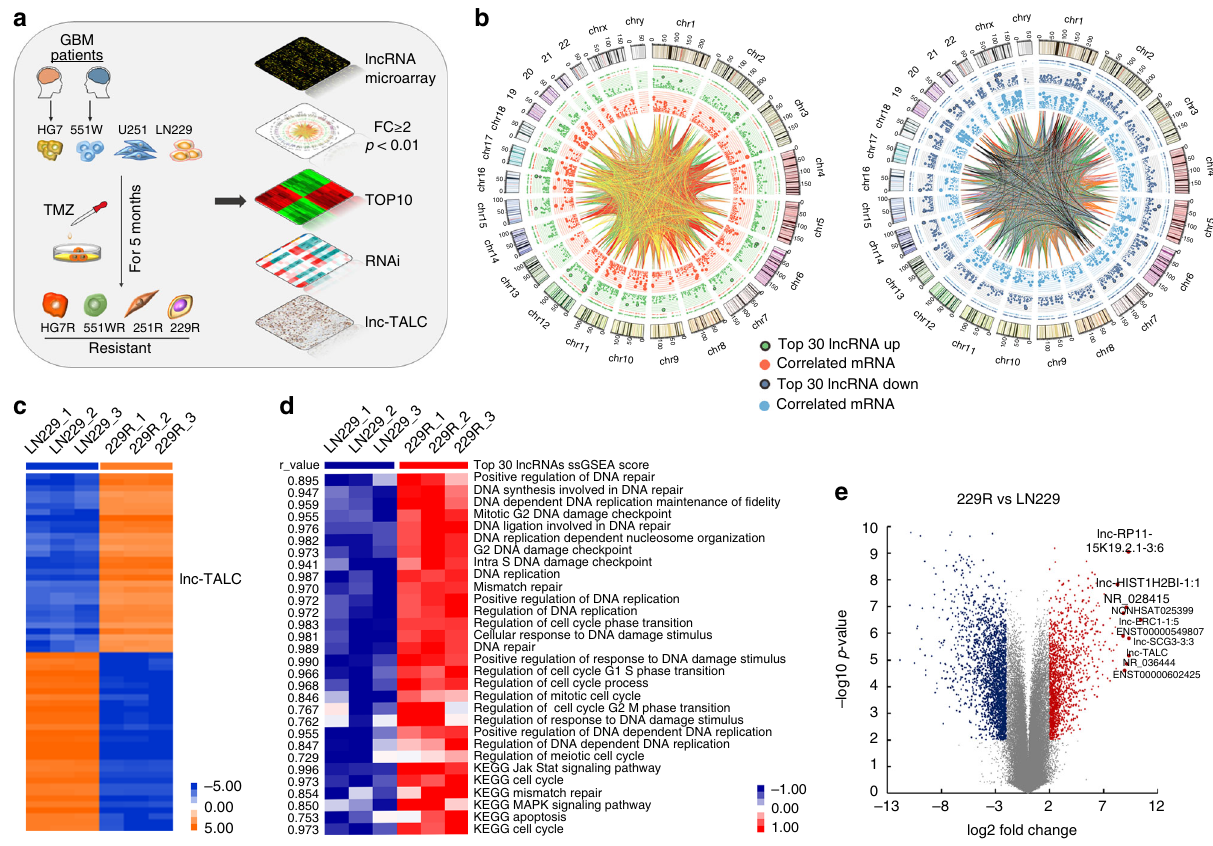
Fig. 1 LncRNA microarray detection of TMZ-resistant and parental GBM cells. a Schematic process to acquire TMZ-resistant GBM cells and to screen the lncRNA lnc-TALC. b The circos plot presents the genome-wide view of the top 30 up- or downregulated lncRNAs and the associations with mRNAs of TMZ-resistant GBM cells. c The heatmap shows the top 30 up- and downregulated lncRNAs in TMZ-resistant GBM cells. d The top 30 upregulated lncRNAs associated with functional gene sets of TMZ-resistant GBM cells are shown in the heatmap. e The top 10 upregulated lncRNAs between LN229 and 229R cells are listed in the volcano plot of DNA methyltransferase also had no effect on the lnc-TALC then selected 56 patients diagnosed with GBM and treated by expression in GBM cells (Supplementary Fig. 3b). TMZ chemotherapy from the Cancer Genome Atlas (TCGA) RPPA protein expression database. We found higher levels of AKT-pS473-R-V ( p = 0.0236) and c-Met_pY1235-R-C ( p = 0.0485) in samples with shorter survival times (Supplementary Fig. 4a). Moreover, we observed that the expression levels of RTK molecules were much higher in 229R cells through analyzing mRNA microarray pro fi les (Fig. 4a). We also investigated 502 GBM samples, including 483 primary GBM samples and 19 recurrent GBM samples, from the TCGA database. Differentially than in parental cells (Fig. 3b). Transfection of constitutively active expressed genes were selected (FDR < 0.05), and MET had a FOXO3 signi fi cantly downregulated lnc-TALC levels in TMZ- higher level in recurrent GBM samples (Supplementary Fig. 4b). resistant cells, whereas DNA-binding domain-truncated mutants TMZ-resistant GBM cells showed a higher level of c-Met and p- (FOXO3-Mut) had no effect on lnc-TALC levels (Fig. 3c). Knock- Met than did parental GBM cells (Fig. 4b). We observed the down of AKT in TMZ-resistant cells decreased lnc-TALC but effects of lnc-TALC on Met expression in TMZ-resistant GBM increased the level and nuclear translocation of FOXO3 (Fig. 3d, e). cells by knocking down lnc-TALC and parental GBM cells by We performed chromatin immunoprecipitation (ChIP)-PCR assay overexpressing lnc-TALC . Knockdown of lnc-TALC decreased the to detect the enrichment of FOXO3 on the promoter region of lnc- c-Met and p-Met levels, and overexpression of lnc-TALC TALC , whereas the enrichment was signi fi cantly decreased in TMZ- increased the c-Met and p-Met levels (Fig. 4c – f). Over- resistant cells (Fig. 3f). The histone deacetylase inhibitors, expression of MET restored the resistant phenotype and down- suberoylanilide hydroxamic acid (SAHA) and sodium butyrate stream signaling in TMZ-resistant GBM cells with knocked-down (NaB), abolished the FOXO3-triggered transcriptional suppression lnc-TALC (Fig. 4g, h and Supplementary Fig. 4c, d). Conversely, of lnc-TALC (Fig. 3g). knockdown of MET inhibited the resistant phenotype and the downstream signaling in parental GBM cells overexpressing lnc- TALC (Fig. 4i, j and Supplementary Fig. 4e, f). Consistently, SGX- 523, a small-molecule inhibitor of c-Met, restored the sensitivity and the downstream signaling of parental GBM cells after the NATURE COMMUNICATIONS| (2019) 10:2045